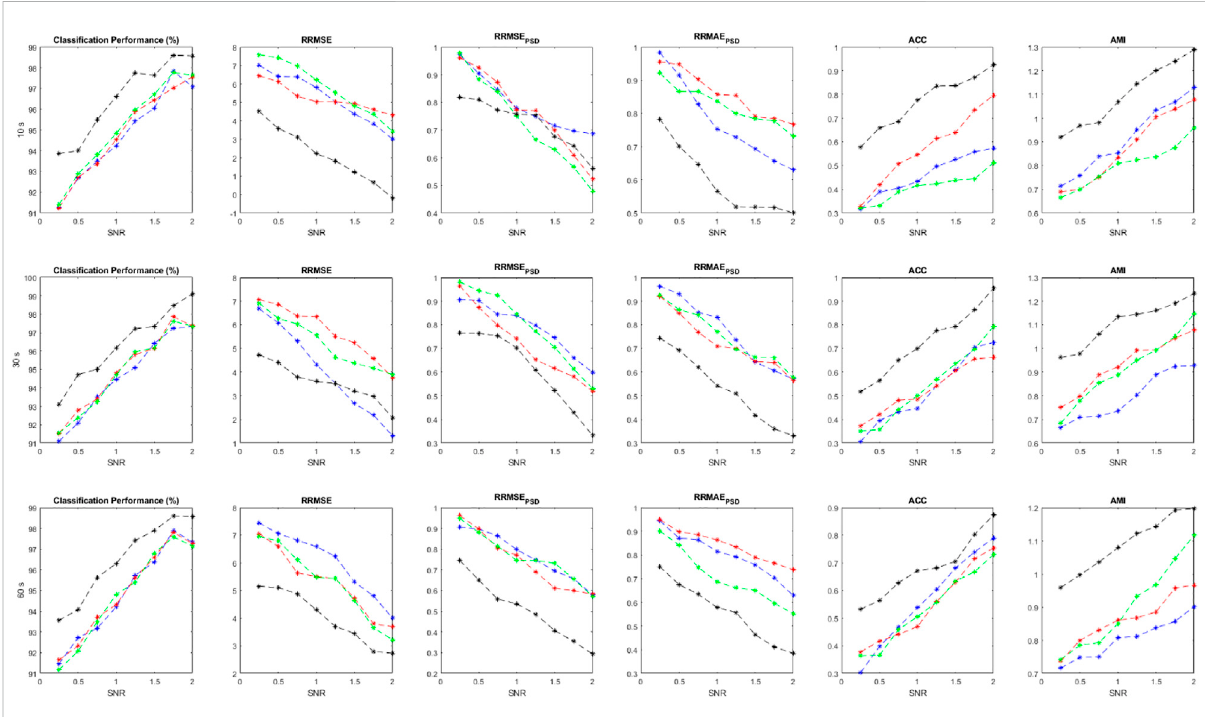
FIGURE 5 Performanceparametersusingsimulateddataatvarious SNRvalueandevaluationcriteria,including ACP , RRMSE , RRMSE PSD , RRMAE PSD , ACC , and AMI .